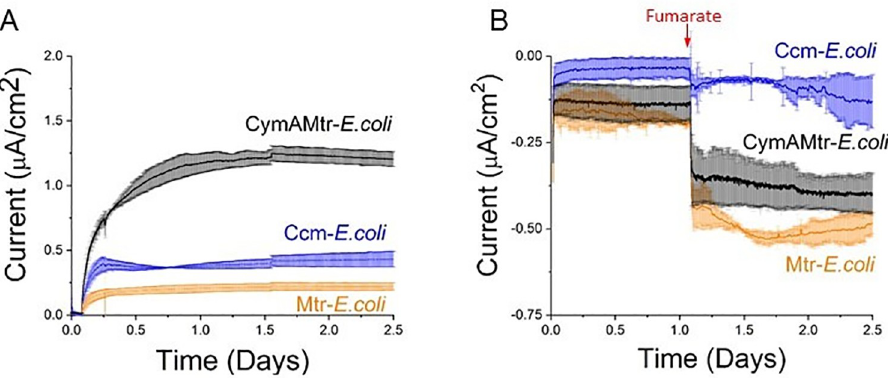
Fig 2. Expression of mtrCAB from S . oneidensis MR-1 allows Escherichia coli to directly produce or consume current. (A) Chronoamperometry of bioelectrochemical reactors containing Ccm- E . coli (orange), Mtr- E . coli (orange), or CymAMtr- E . coli (black) in the anodic compartment with the anode poised to +200 mV Ag/AgCl . Lactate is provided as an electron donor and the anodic chamber is kept anaerobic by bubbling with N 2 (g). (B) Chronoamperometry of bioelectrochemical reactors containing Ccm- E . coli (orange), Mtr- E . coli (orange), or CymAMtr- E . coli (black) in the cathodic compartment with the cathode poised to -0.56V Ag/AgCl . Addition of 50 mM fumarate is indicated by the red arrow. The error bars indicate the standard deviation in current from three bioreactors.